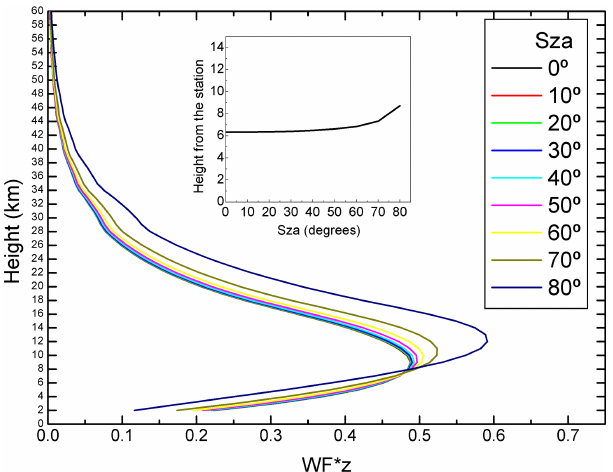
Figure 4. Scattering height versus weighted intensity times the alti- tude for different